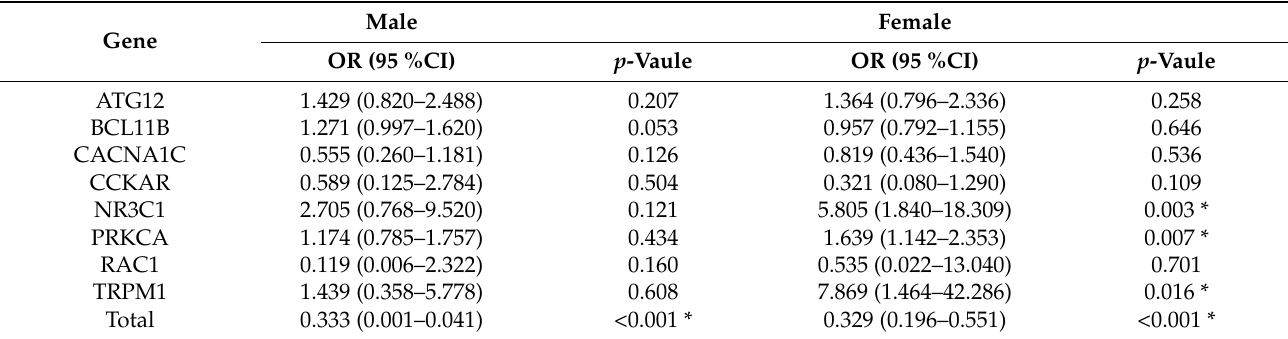
Table 4. The subgroup analysis of the relationship between PRSs of calcium signaling pathway and MCI.